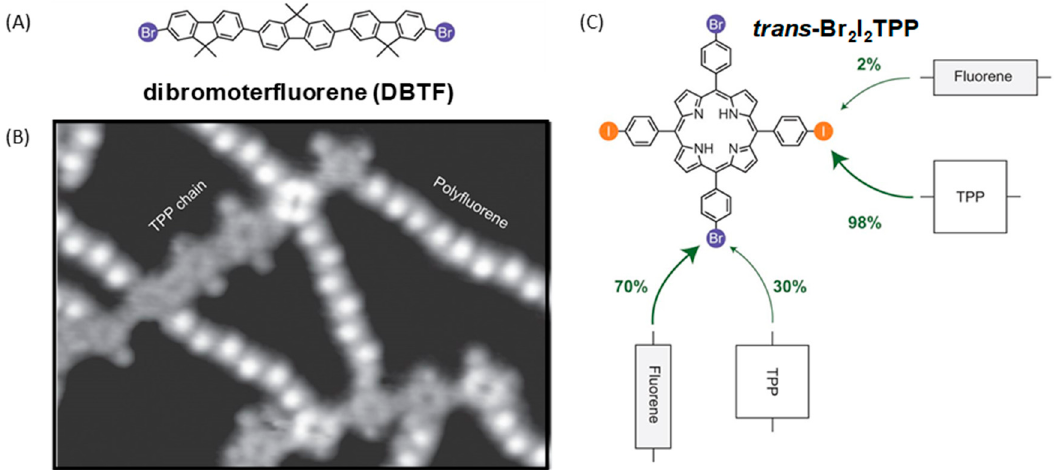
Figure 6. ( A ) Chemical structure of dibromoterfluorene (DBTF). ( B ) STM topograph of the copolymerization of 5,15- bis (4 ′ -bromophenyl)-10,20- bis (4 ′ -iodophenyl)porphyrin ( trans -Br 2 I 2 TPP) with DBTF (13 × 18 nm²). ( C ) Statistical analyses of the porphyrin/TBTF connection. Reprinted by permission from Macmillan Publishers Ltd: Nature Chemistry from [83], copyright 2012.